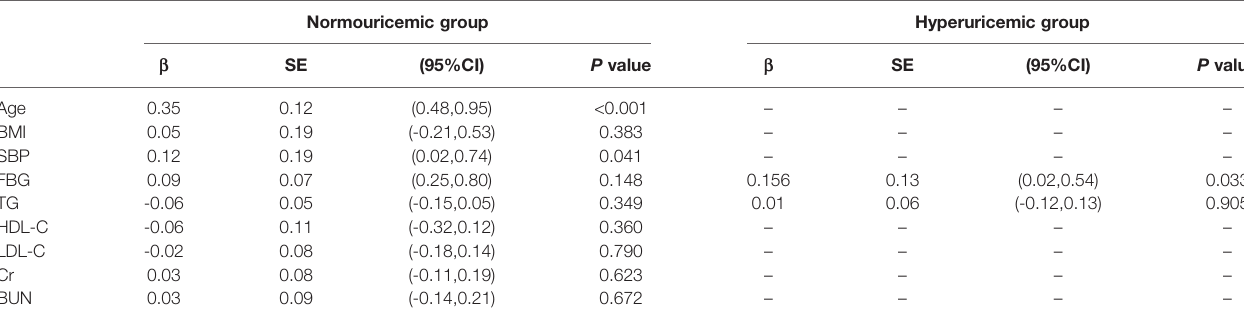
TABLE 4 | Determinants of traditional risk factors for CIMT in different SUA groups in a multivariate analysis.